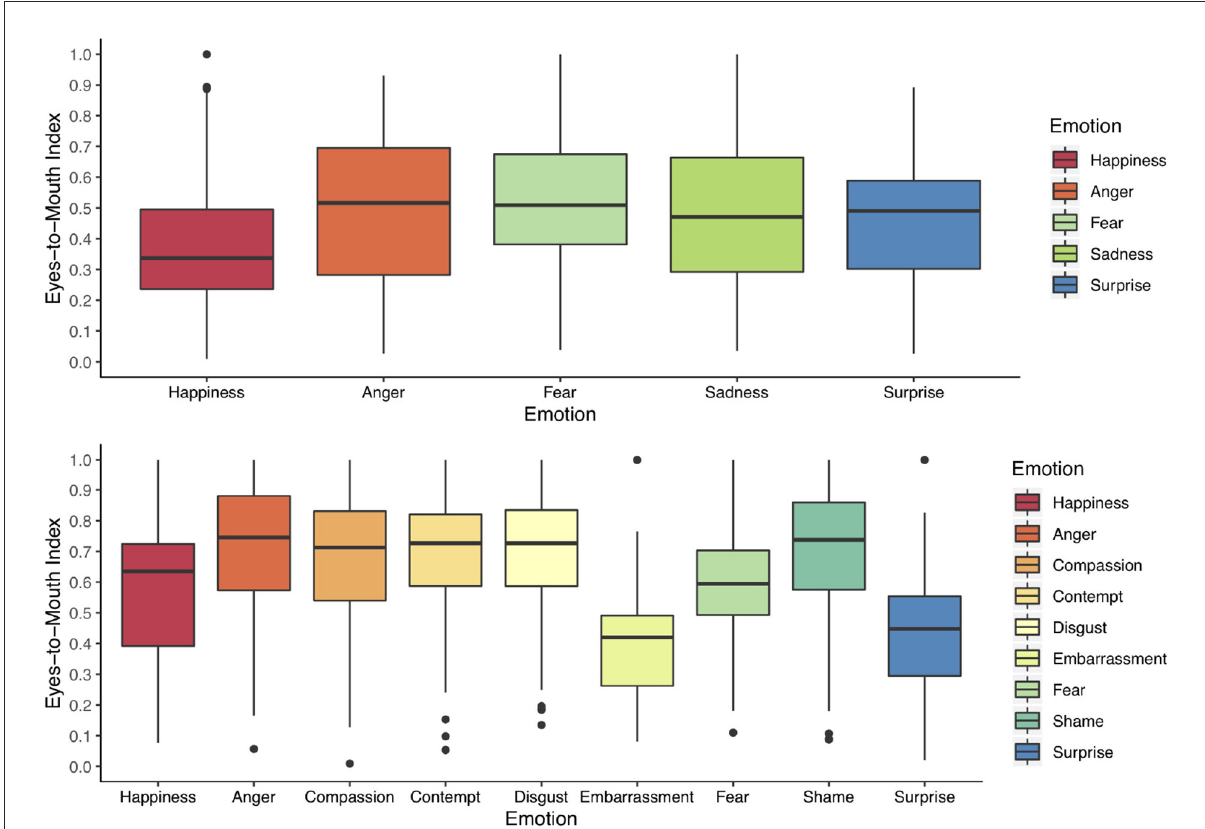
FIGURE2 Children’s eyes-to-mouth index for each emotion in the Child Faces Task (top) and the Adult Faces Task (bottom) . The greater the eyes-to-mouth index the longer children looked at the eye area compared to the mouth area. An eyes-to-mouth index of 0.5 indicates equivalent fixation duration to the eyes and the mouth